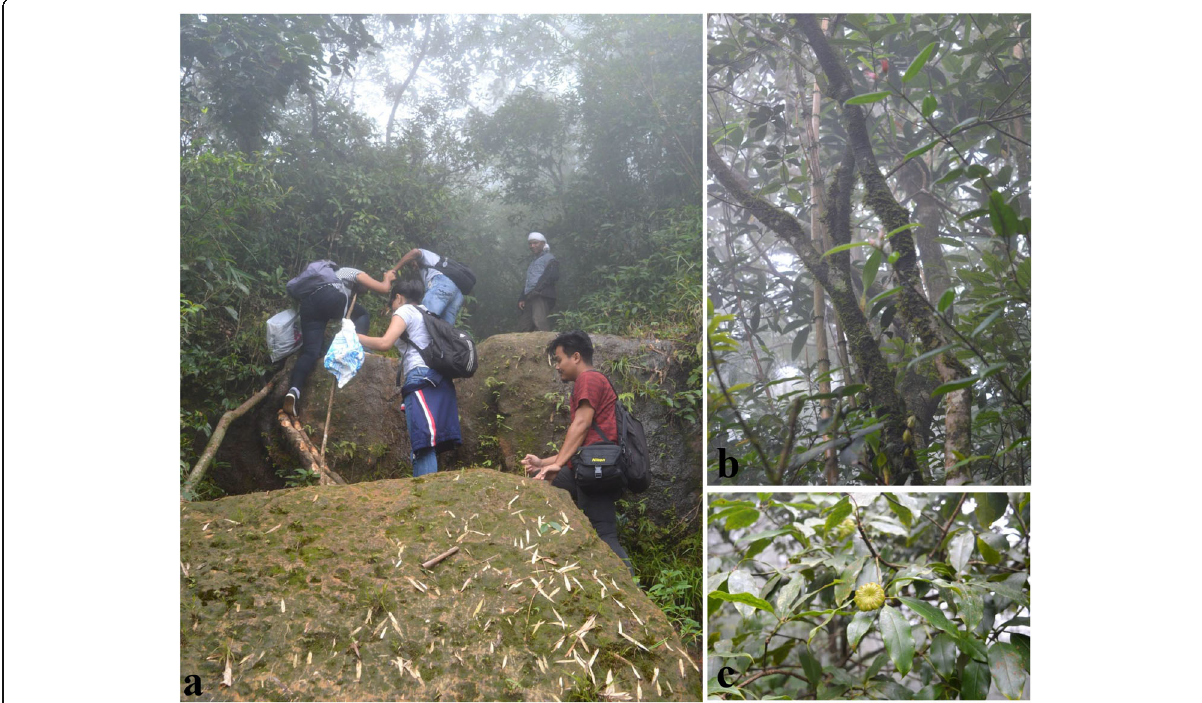
Fig. 1 Collection of samples from different locations; a field collection, b I . griffithii plant, c I . griffithii plant bearing